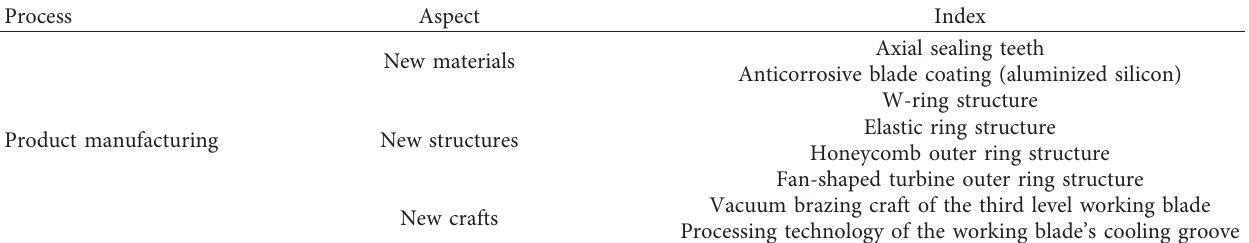
Table 4: New materials, structures, and crafts in company G’s manufacturing